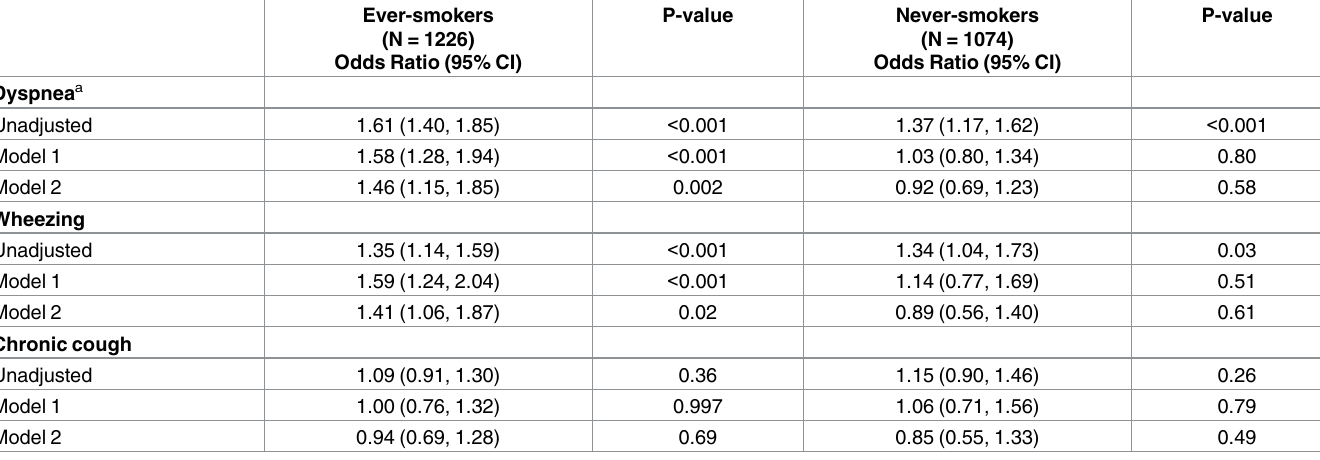
Table 3. Association of respiratory symptoms with 1 standard deviation lower total pulmonary vascularvolume stratified by smoking history.